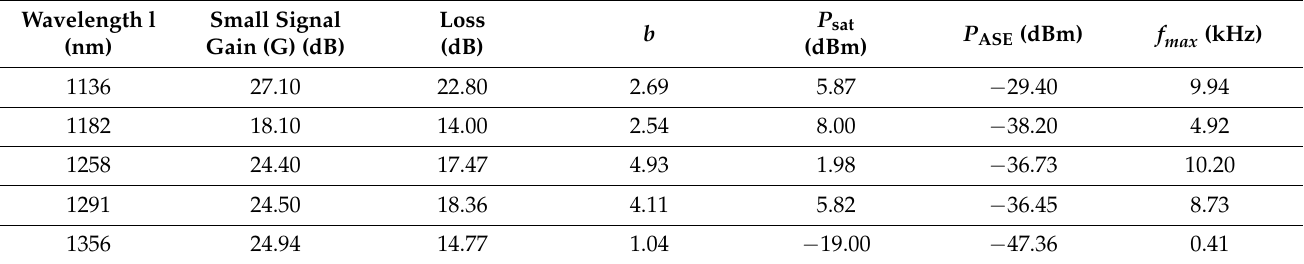
Table 1. Small signal gain and loss per cycle and calculated frequencies of saturation limit at each wavelength from the broadband.